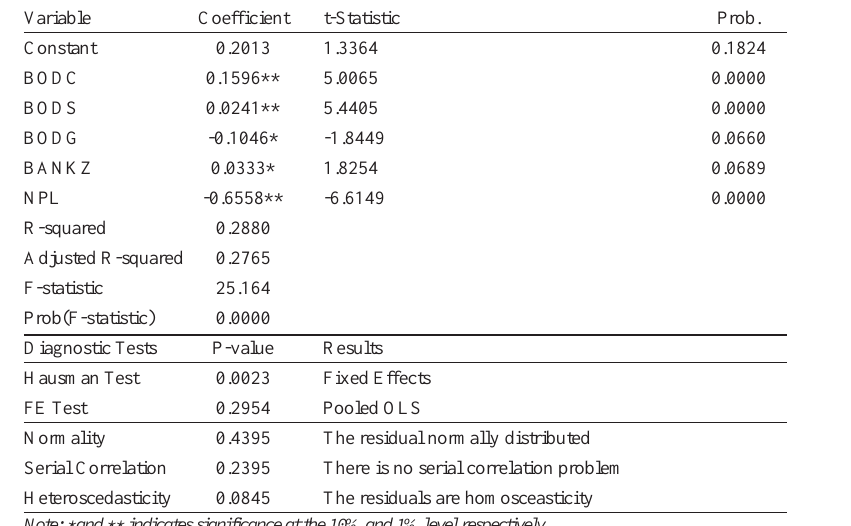
Table 3 Board characteristics and bank performance